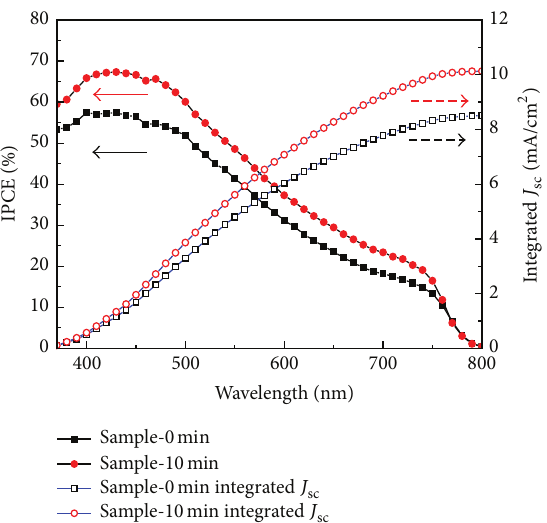
Figure 9: XRD patterns of MAPbI 3 thin films. The MAPbI 3 depended on the PbI 2 , which is deposited for different drying time.